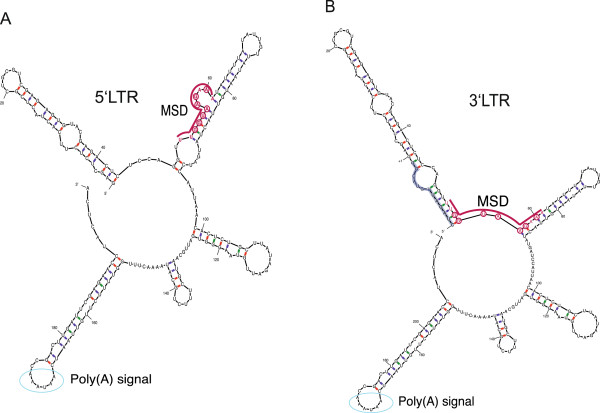
SHAPE analysis of the RNA structure from (A)+1 to+198 and from (B)−13 to+198. Secondary structure models of both RNAs developed using SHAPE constraints are shown. The positions of the MSD and polyadenylation signal are indicated and the region from −13 to −1 is shaded in violet. Nucleotides complementary to the U1snRNA are circled (red) and the position of the poly(A) signal is marked by blue circles.